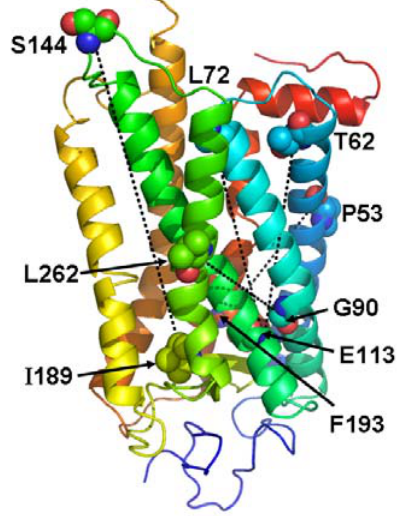
Figure 5. Rhodopsin structure highlighting the predicted network of communication path from the EC to CP domain. The significant edges representing the predicted network of interactions are highlighted as dashed lines and colored black. The residues that participate in the predicted network of interactions are labeled and rendered as